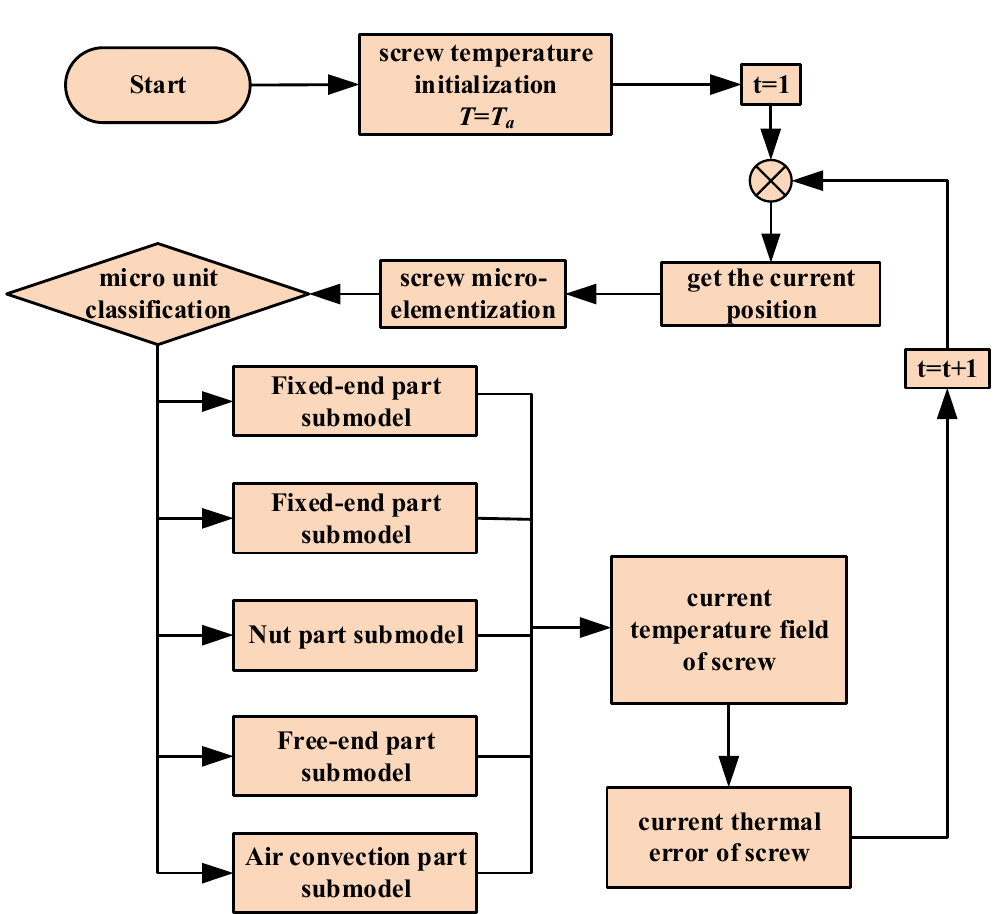
Figure 4. Flowchart of screw thermal error prediction.